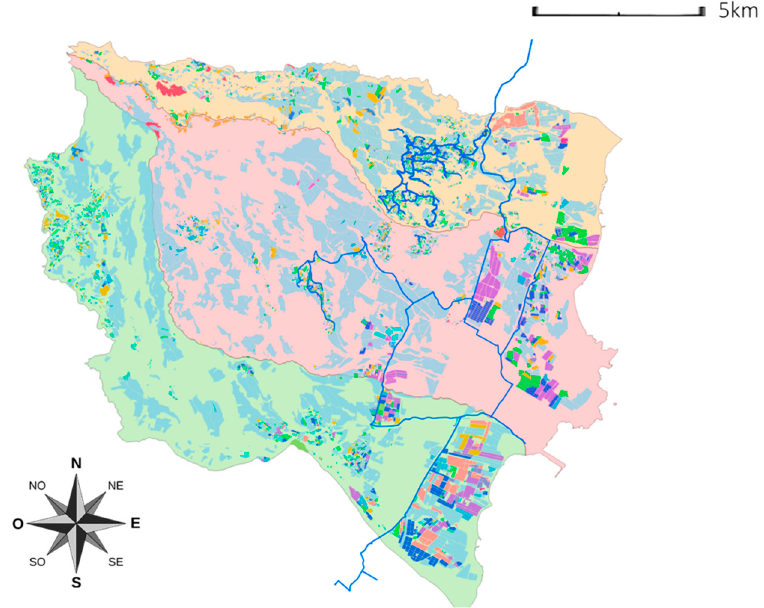
Figure 2. Map of crops’ determination in the Southeast of Gran Canaria island including the reclaimed water network (blue line) in the area. Source: IDECanarias (https://visor.grafcan.es/visorweb/ on the 15 June 2018). Own elaboration.